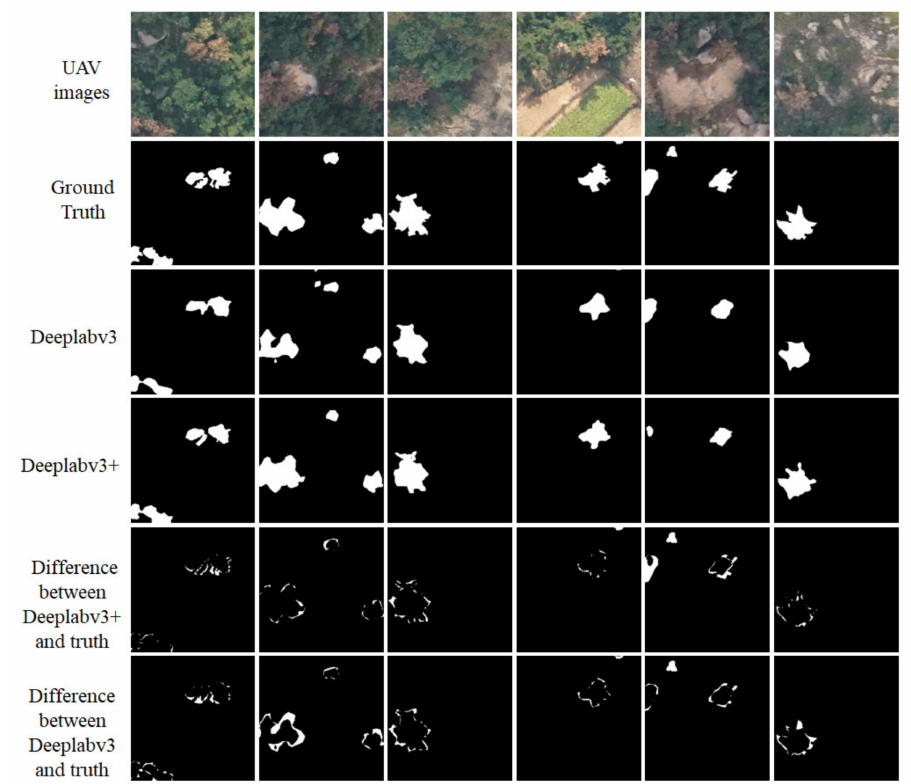
Figure 6. Segmenting results of DeepLabv3 and DeepLabv3+ using the ResNet34 backbone.